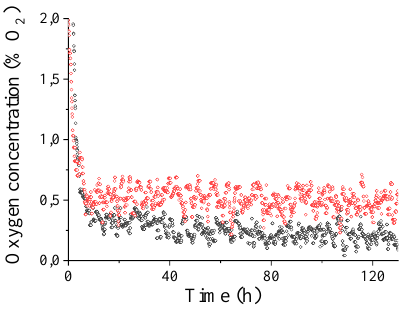
Figure 11. % O 2 measured every 5 min by two sensors placed in an Amarone tank at 10 cm and 210 cm from the overflow surface of the wine. Red: depth 10 cm (1040 bar, 20 ◦ C) average concentration O 2 = 0.50%. Black: depth 210 cm (1220 bar, 19 ◦ C) average concentration O 2 =